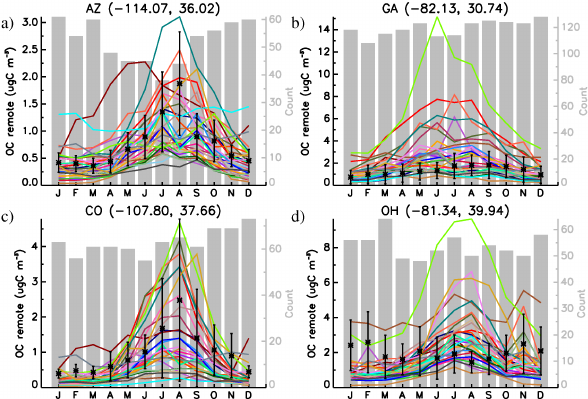
Figure 17. Same as in Fig. 16, for remote stations. Arizona ( a ; 114.07 ◦ W, 36.02 ◦ N, years 2000–2006); Georgia ( b ; 82.13 ◦